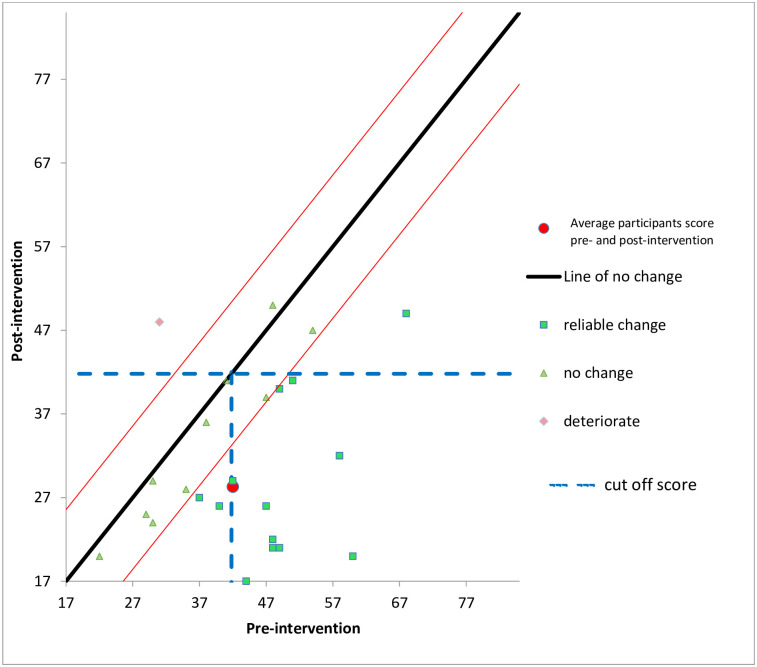
Reliable and clinically significant change in PTSD symptoms (using Criterion C for PCL-M) at 2 weeks follow up, study one.(N = 30).